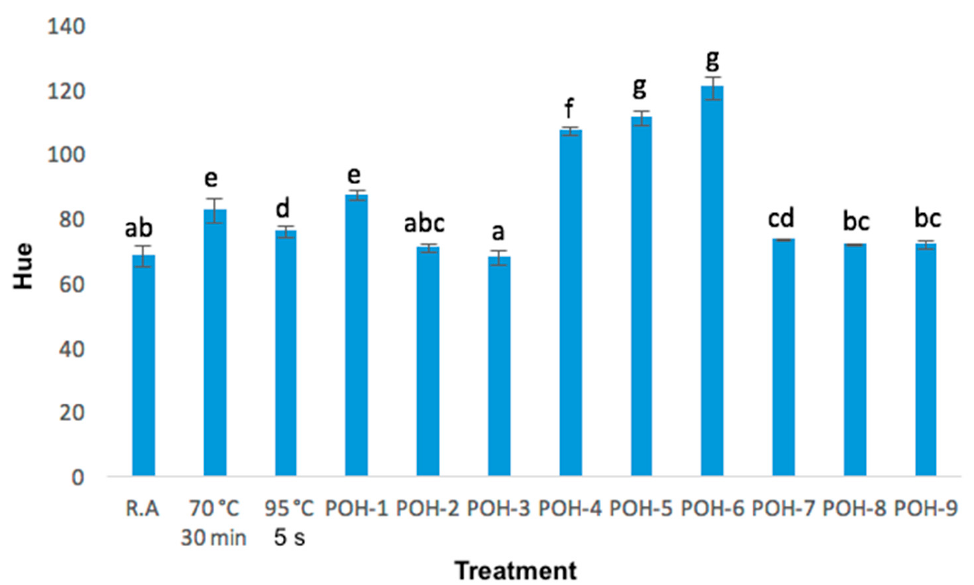
Figure 5. Changes in the hue in raw aguamiel and after pasteurization and ohmic heating treatments; data is mean ( ± standard deviation) of three replicates. a, b, c, d, e, f, g letters indicate significant differences ( p < 0.05).